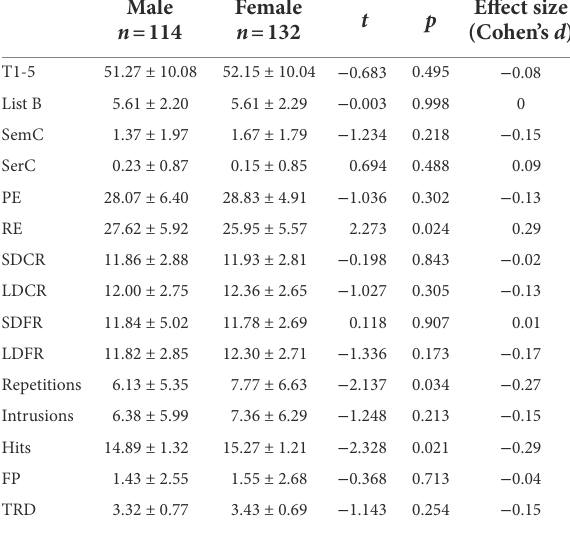
TABLE 4 Comparison of CVLT-II factors between healthy male and female